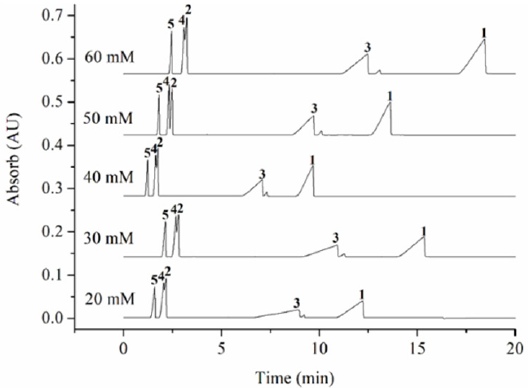
Figure 1. Electropherograms of five compounds at different buffer concentrations. Running buffer: sodium borax-sodium dihydrogen phosphate system. Separation voltage: 25 kV. Wavelength: 214 nm. The concentrations of analytes: 50 µ g/mL. Inject: (0.5 psi, 10 s). The compounds represented by the numbers 1–5 are listed in Table 1.